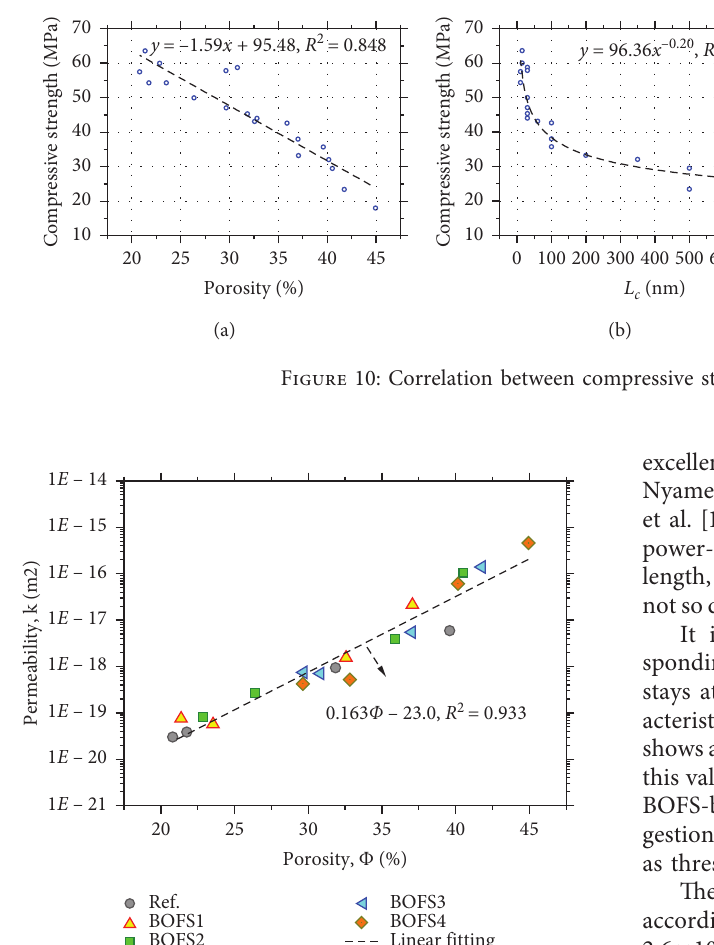
Figure 11: Correlation between permeability and